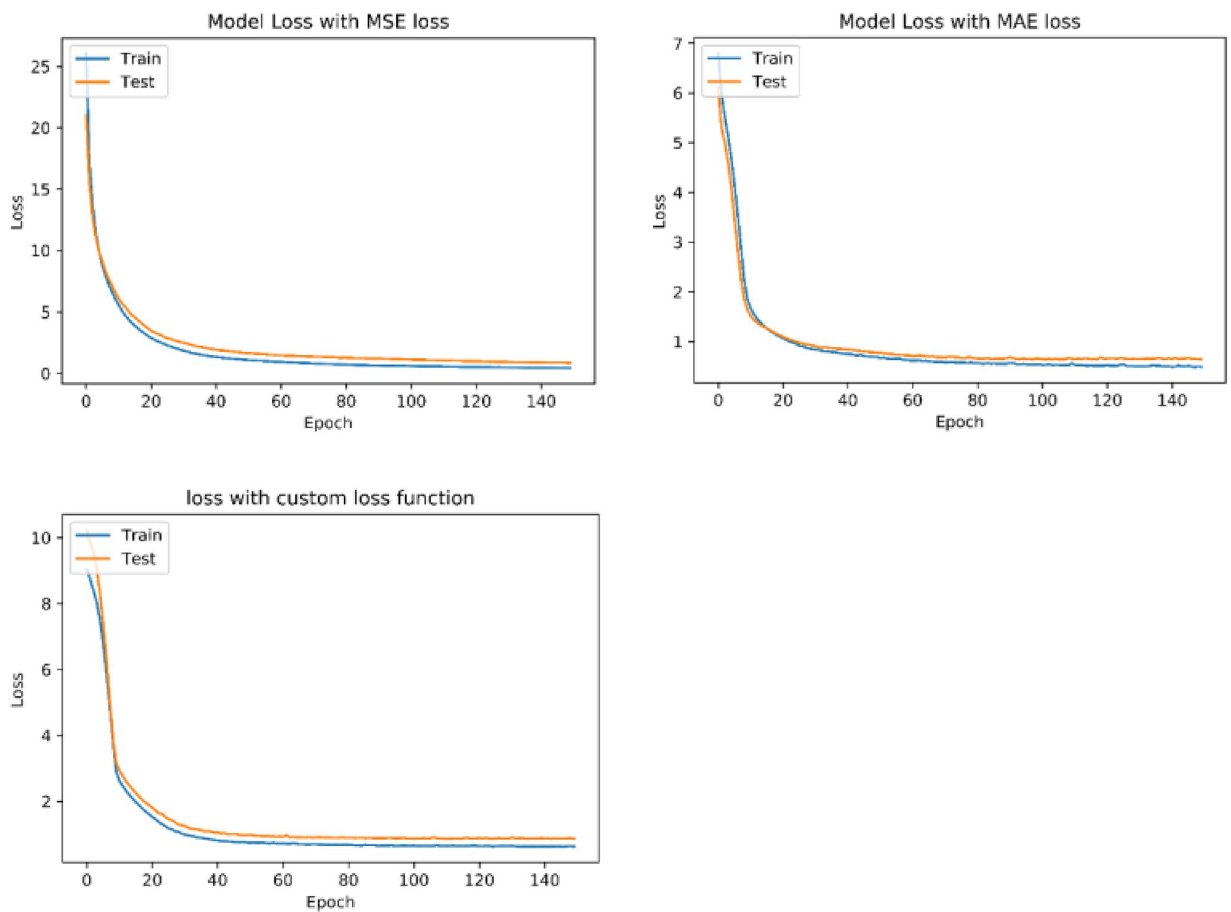
Fig. 13 Loss of bi-directional LSTM-RNN learner 1 while predicting taste ratings with ‘MSE’ (left), ‘MAE’ (middle) and custom loss function(right)